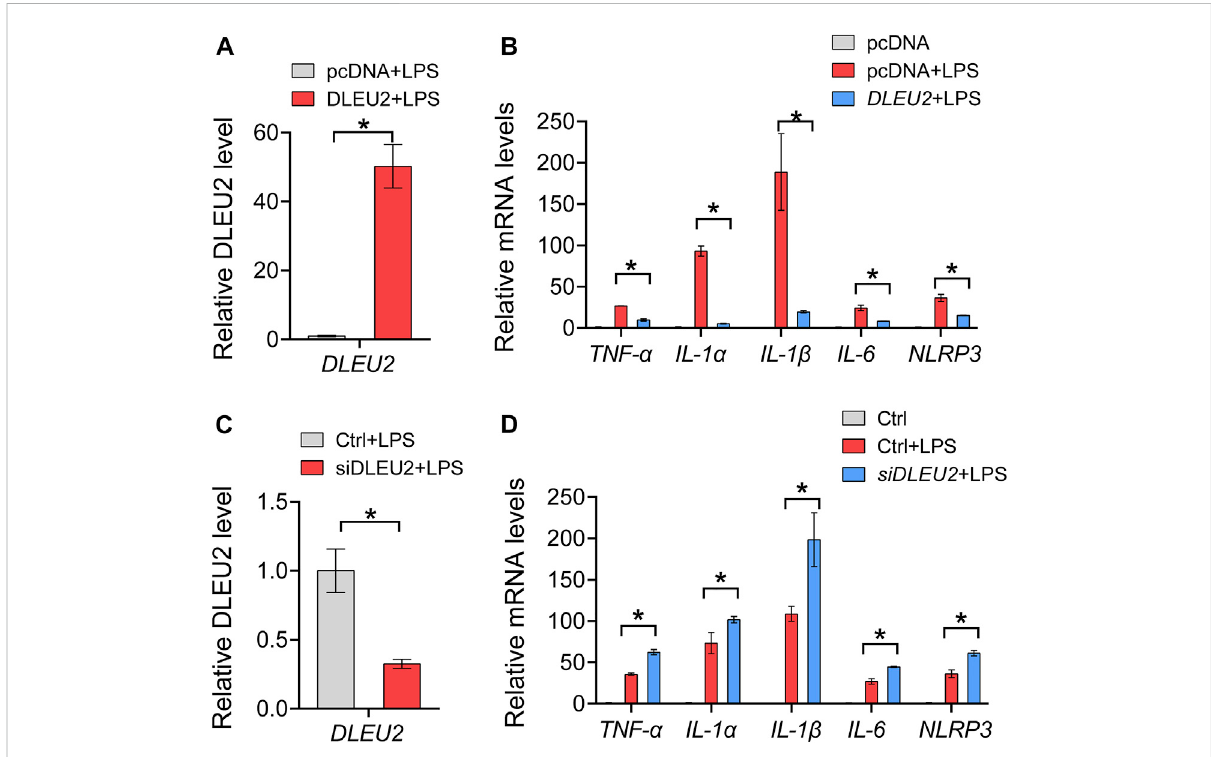
FIGURE 3 DLEU2inhibitsNF- κ B-relatedin fl ammationcytokines. (A) Theexpressionlevel ofDLEU2inDLEU2 andpcDNA(control)treatedTHP-1 cells. (B) Effects of DLEU2 overexpression on level of in fl ammation cytokines in THP-1 cells. (C) The expression level of DLEU2 in siDLEU2 and negative control transfectedTHP-1 cells. (D) EffectsofDLEU2knockdown onlevel ofin fl ammationcytokinesinTHP-1 cells. n =5per group. p < 0.05( t